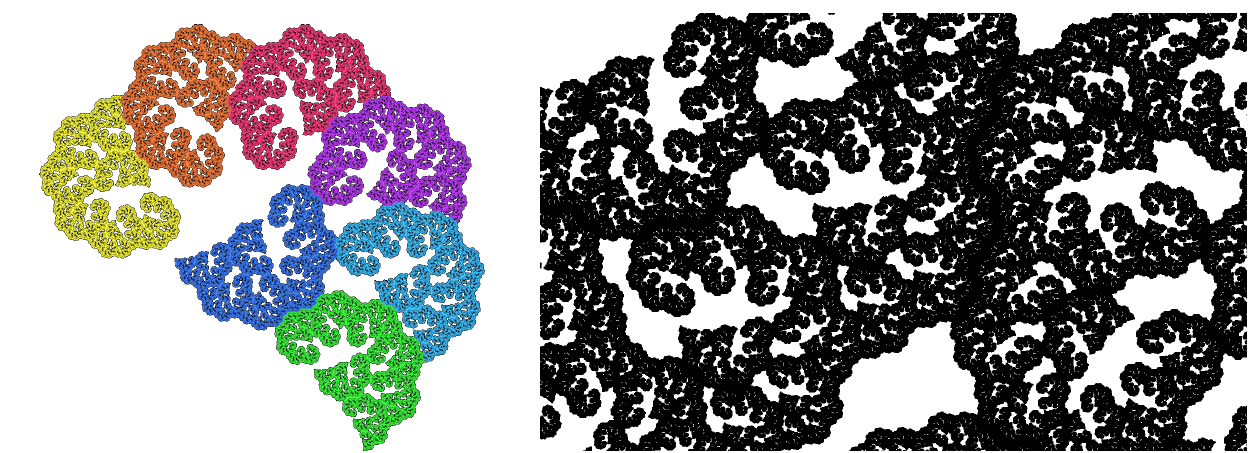
Figure 9. A carpet generated from three irrational rotations with a = 3 determinant of 8. It has dimension 1.87 and 19 neighbor types. The number field is Q ( the tame twindragon.